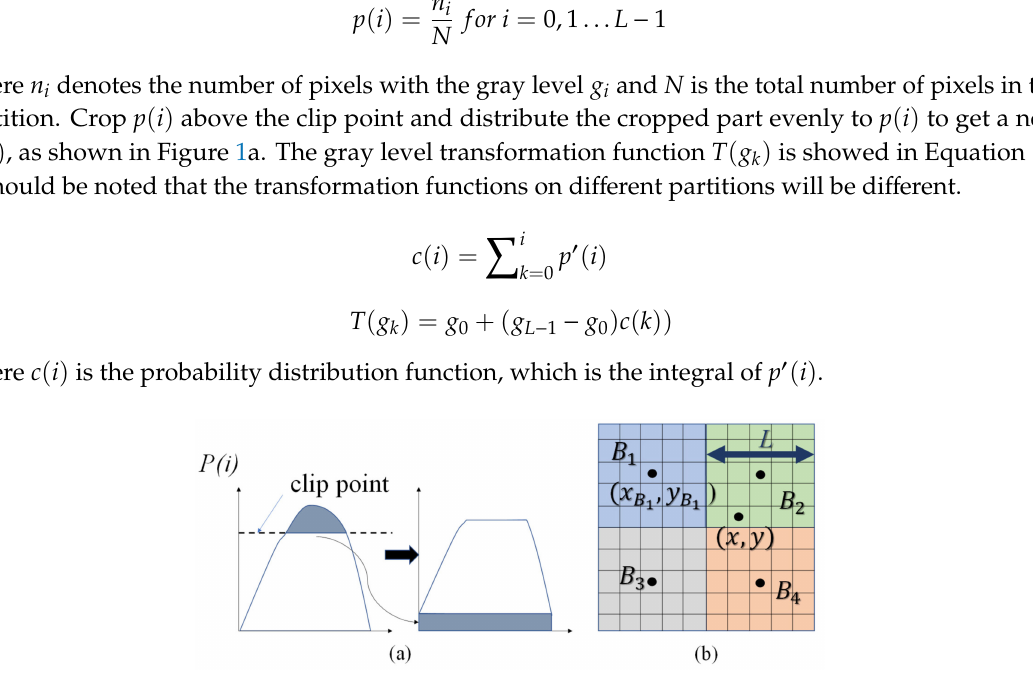
Figure 1. The probability density function (PDF) redistribution and bilinear interpolation within blocks. ( a ) Clip point and redistribution; ( b ) Bilinear